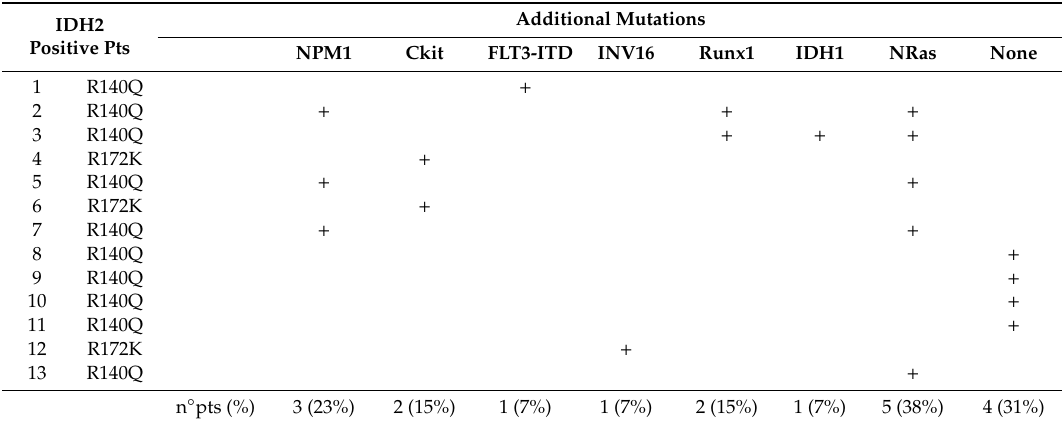
Table 4. Number and type of co-mutations for all IDH2-mutated